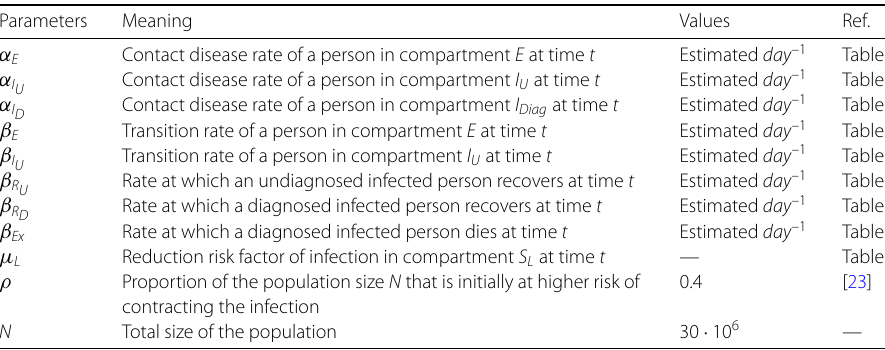
Table 1 Parameters used in model